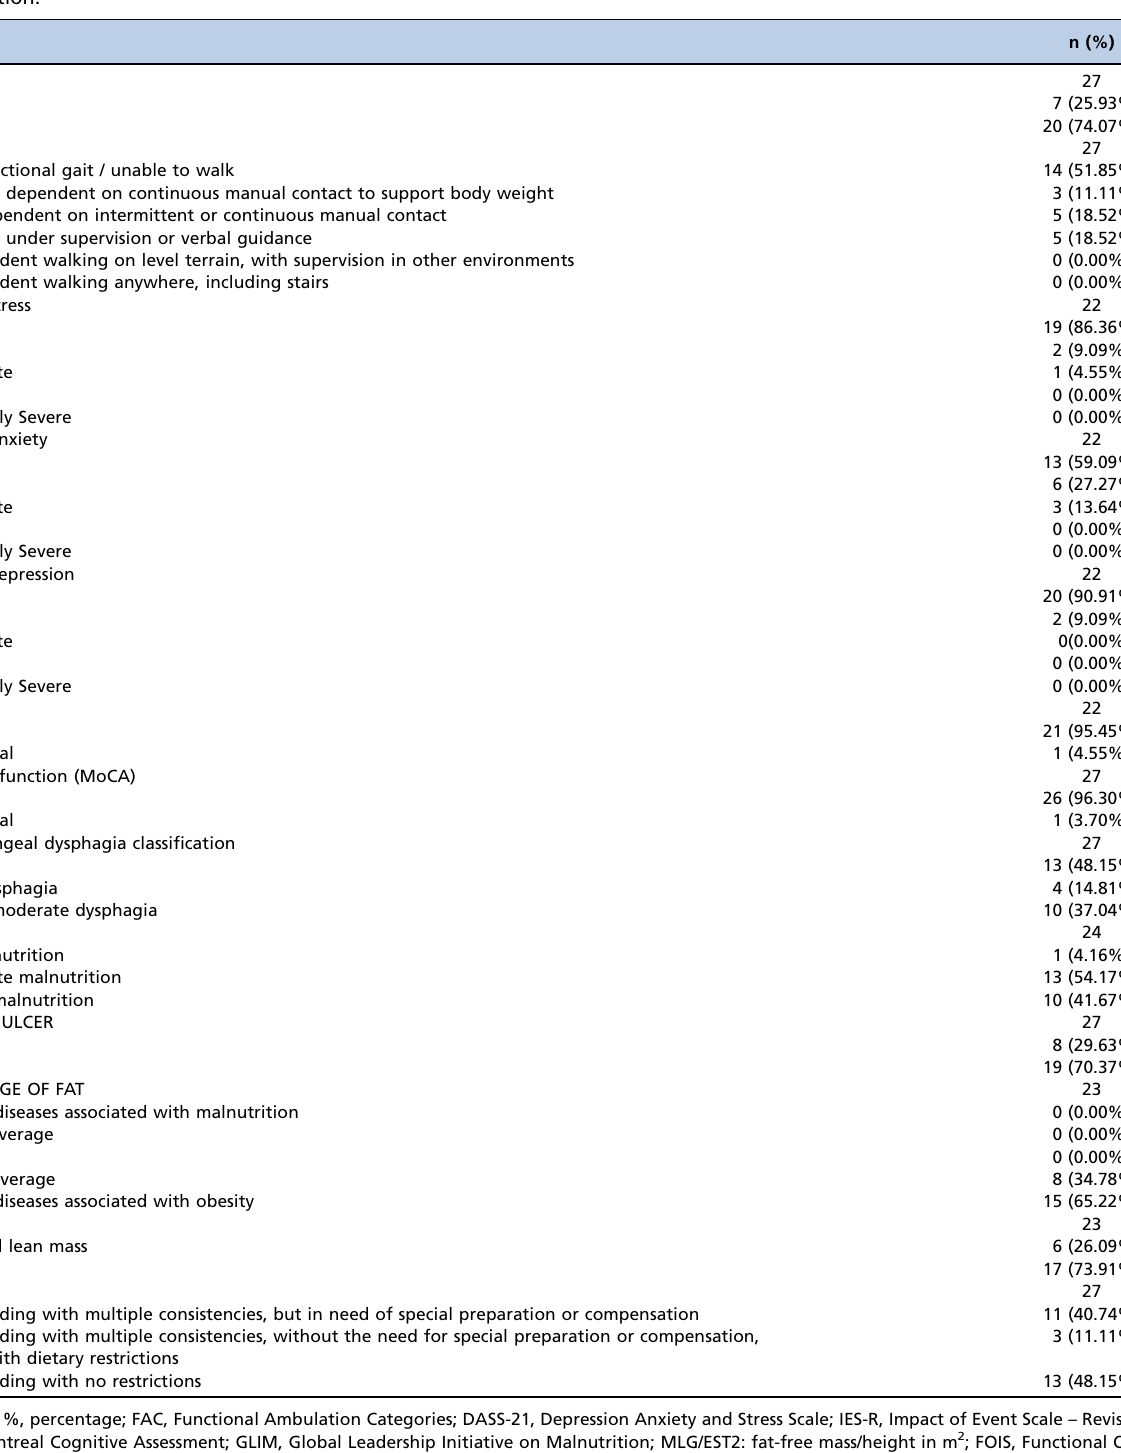
Table 2 - Categorical variables of the baseline demographics and characteristics of the patient population at admission for inpatient rehabilitation.